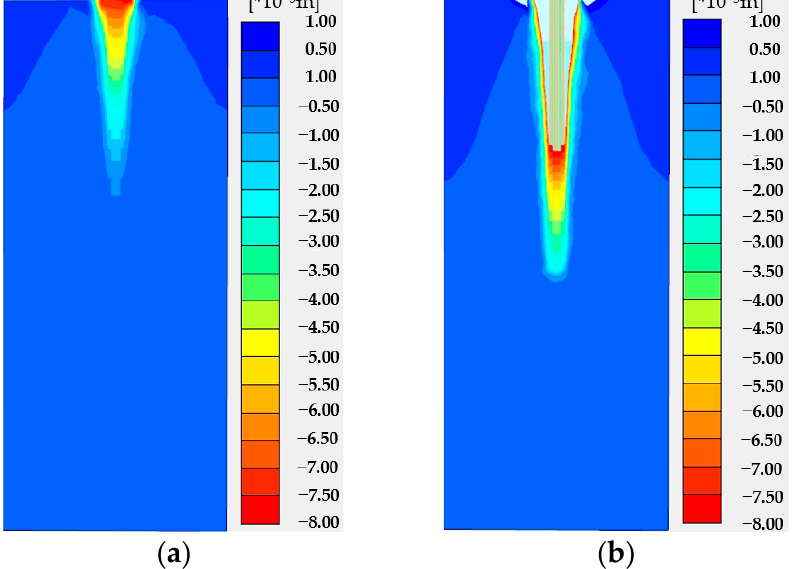
Figure 6. Strain distribution of pile: ( a ) loading to 1650 kN; ( b ) loading to 3300 kN.